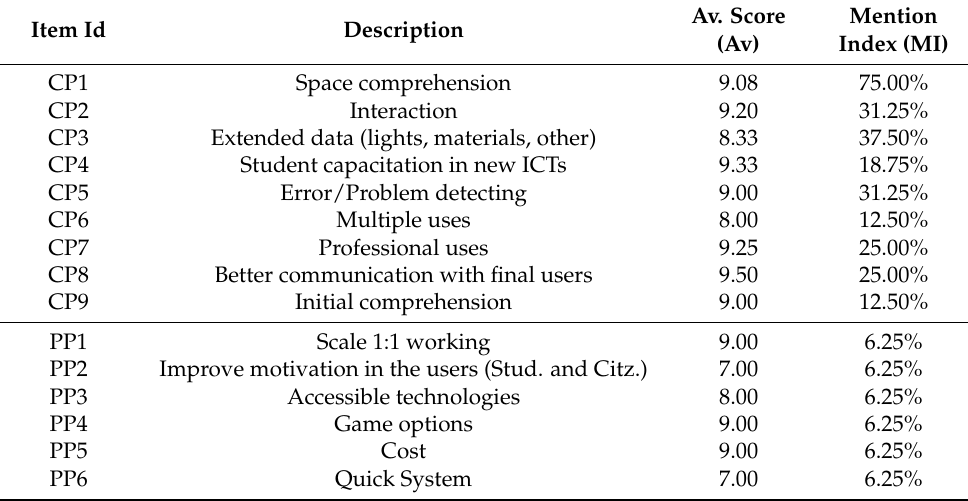
Table 5. BLA positive elements of HMD-VR systems identified.